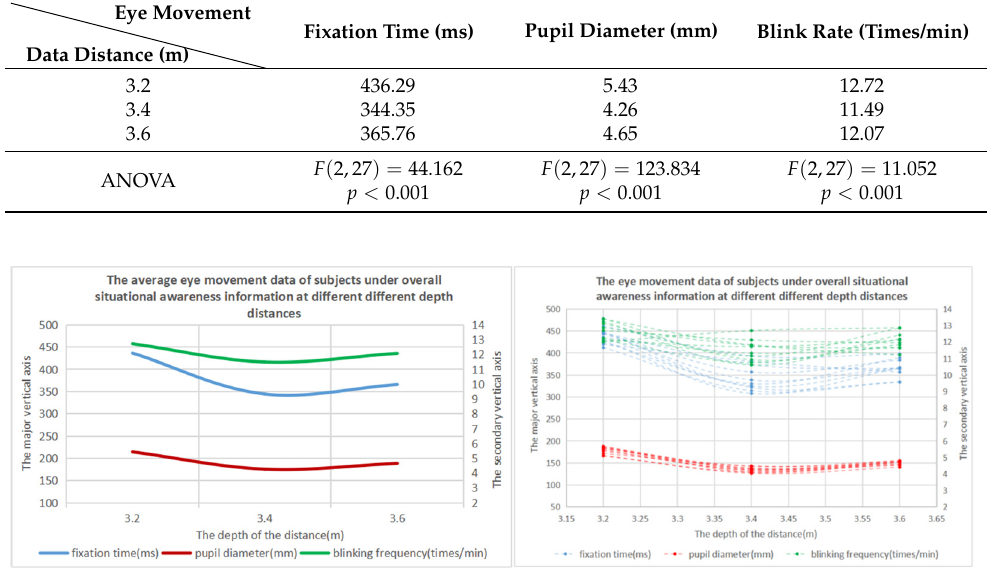
Figure 13. Change trend diagram of the eye movement data of the overall situational awareness information at different depths and distances.